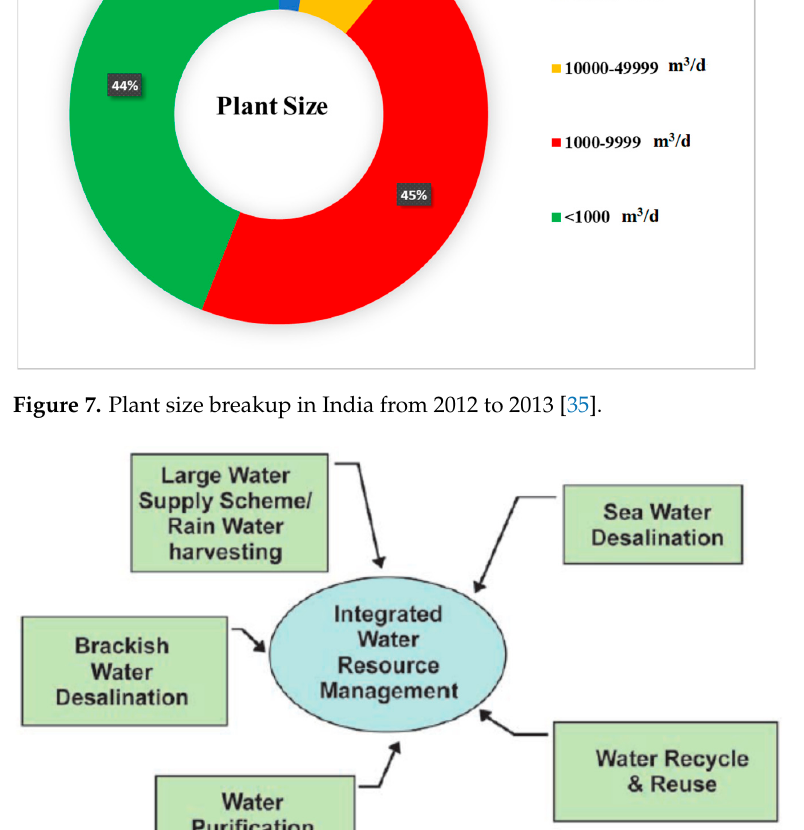
Figure 7. Plant size breakup in India from 2012 to 2013 [35].